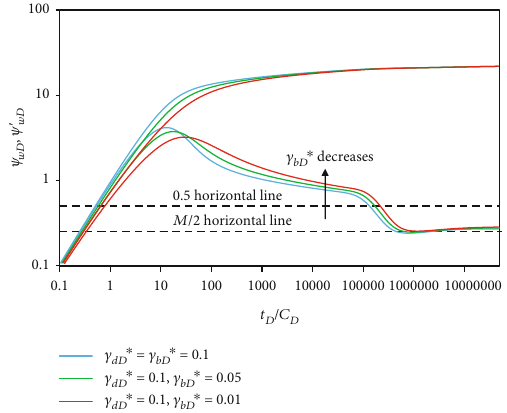
Figure 11: Well test curves of the pressure buildup well test considering the hysteresis e ff ect.